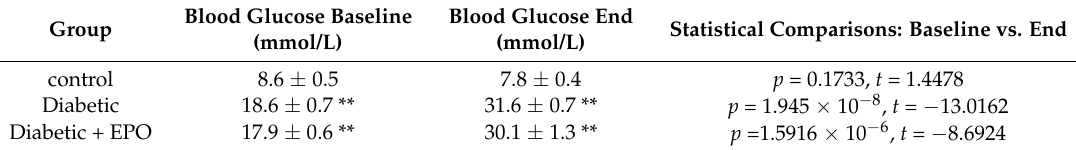
Table 1. Blood glucose